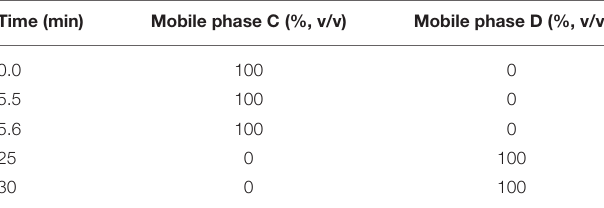
TABLE 2 | Gradient elution program for LC/MS.